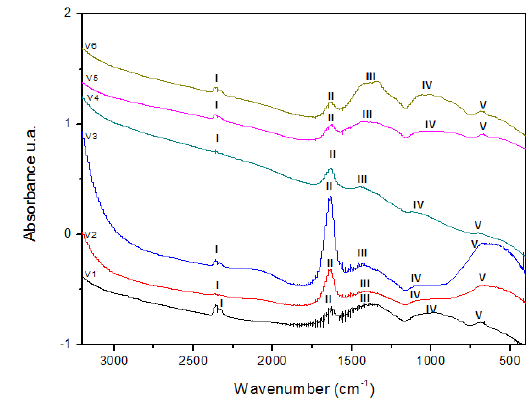
Figure 3. Samples absorption spectra in infrared. Source: the autors